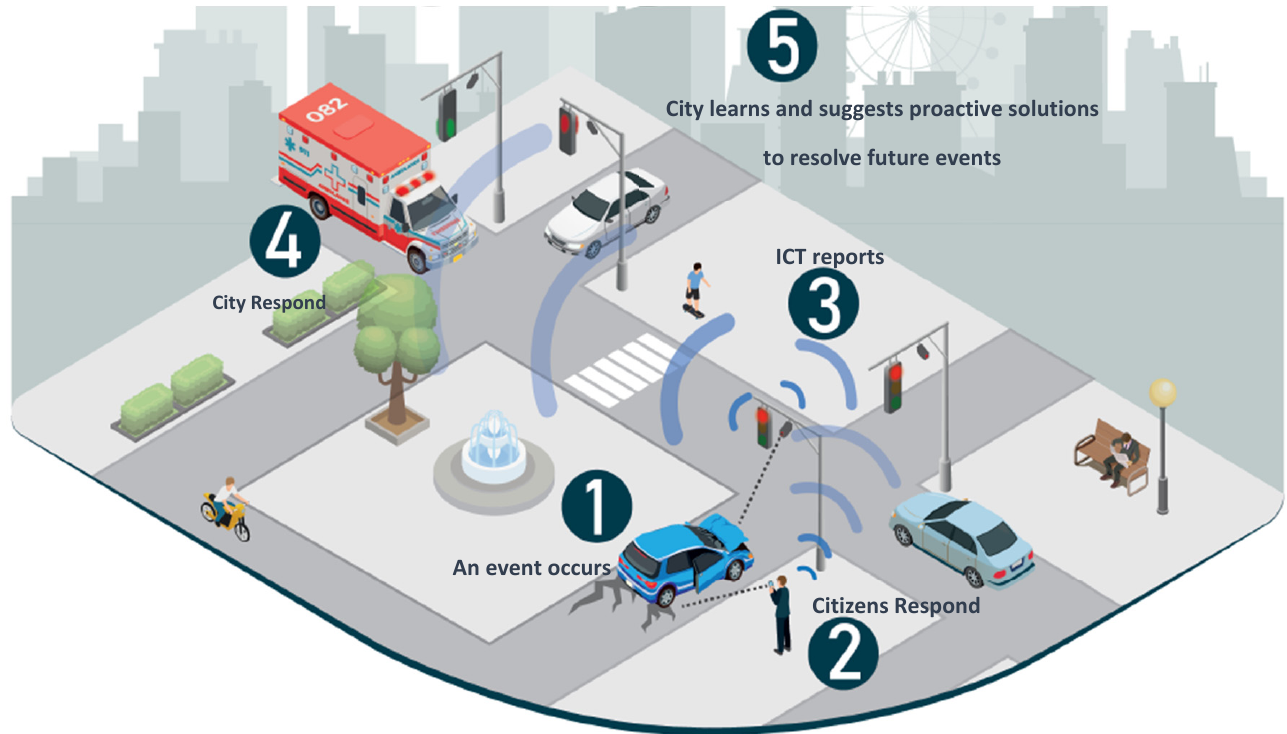
Figure 1. The concept of a cognitive city. Source: [29].